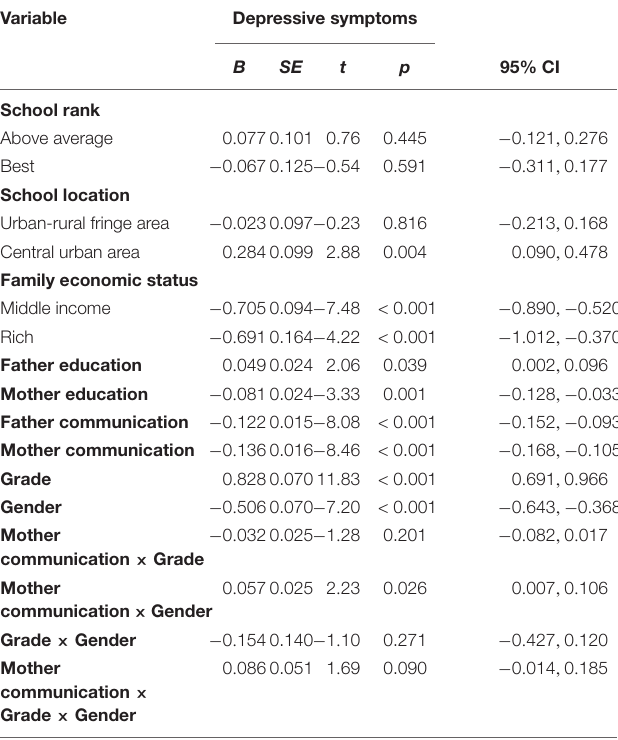
TABLE 7 | Moderating effect of adolescents’ grade and gender on the relation between mother-adolescent communication and adolescents’ depressive